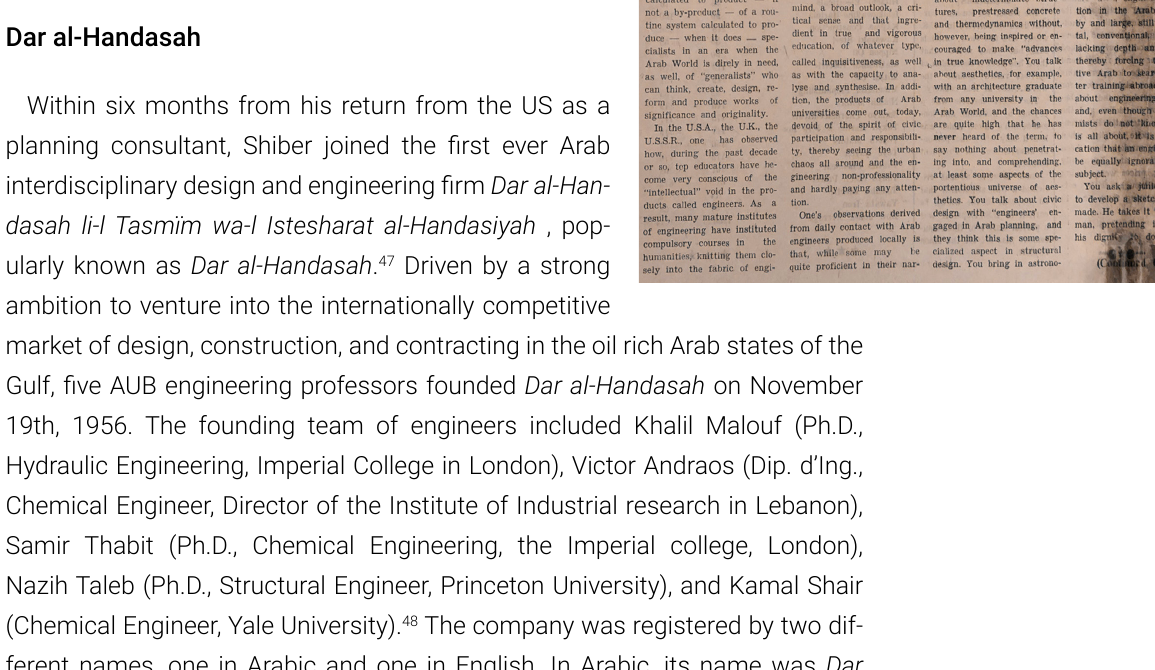
Fig. 14 One of many newspaper articles Shiber wrote in local and regional newspaper about the training of Arab engineers. Source The Daily News, March 9th, 1964, courtesy to Shiber Archive, Washington, DC. ©